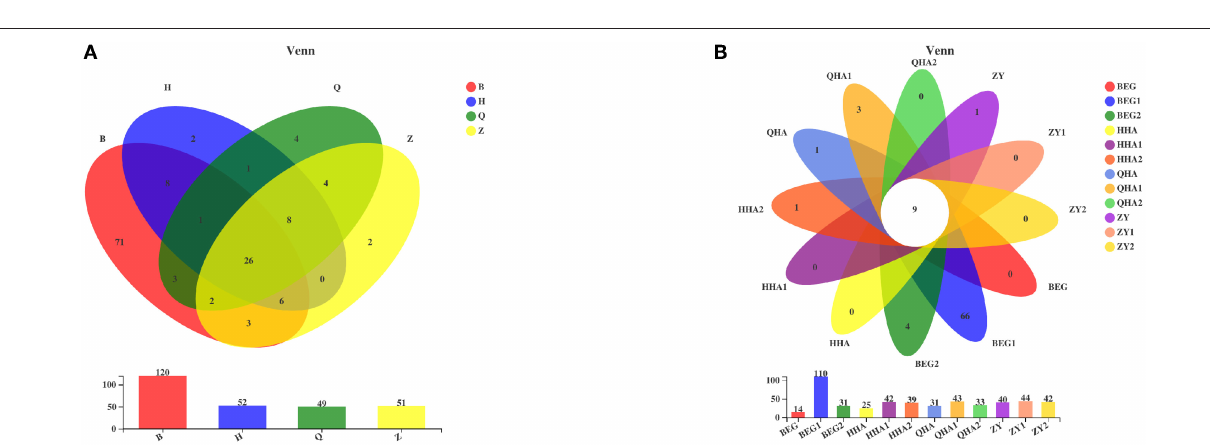
lowest. In general, the bacterial diversity in the Z area is higher than that in other places, as shown in Figures 2A,B